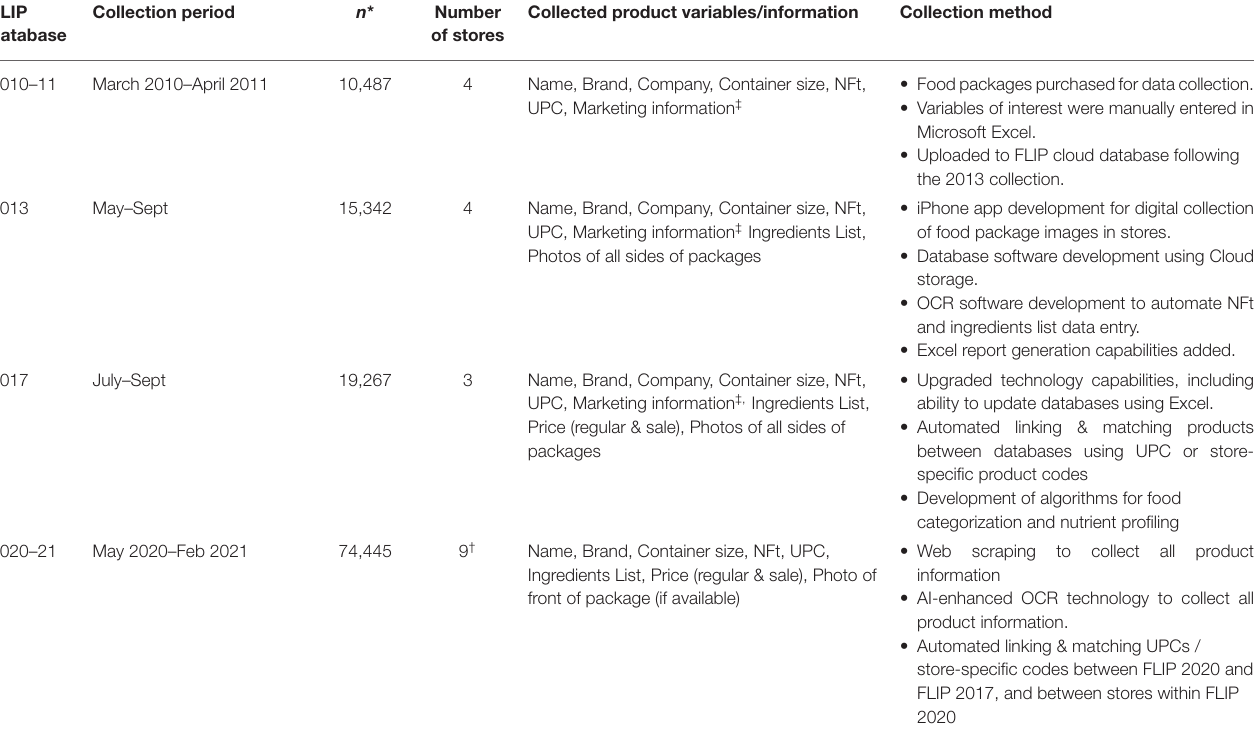
TABLE 1 | History of the Food Label Information Program (FLIP) Database collections and updates. FLIP